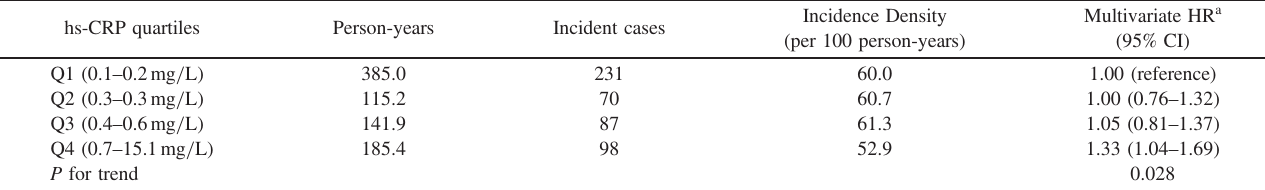
Table 2. Regression of LSIL by hs-CRP quartile hs-CRP